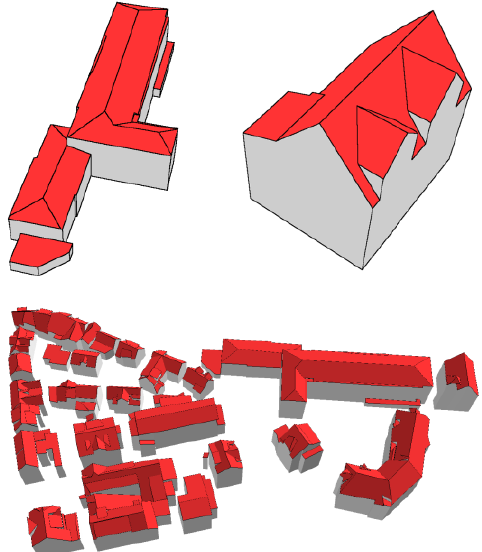
Figure 9. Resulting building models reconstructed by our BSP based reconstruction